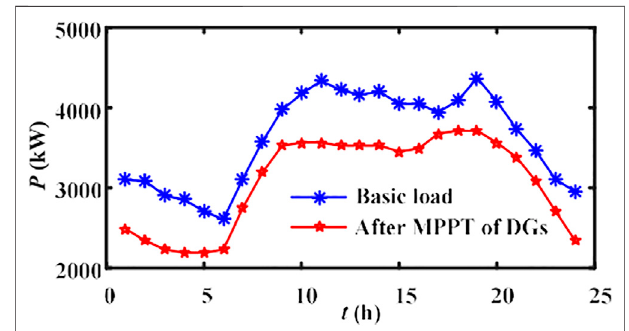
FIGURE 14 | Load curve after MPPT control of DGs.